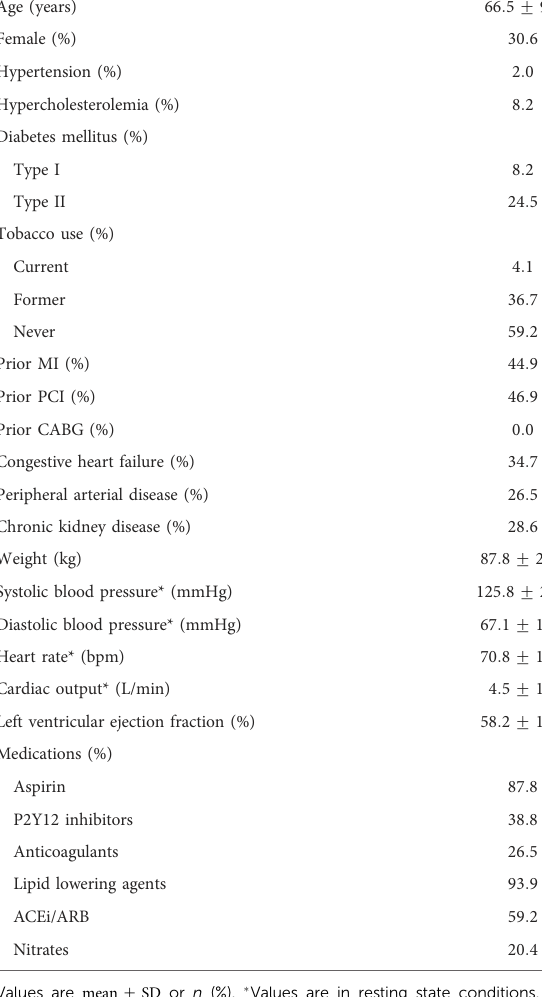
( Figure 4 ) indicated that cardiac output and stenosis degree contributed most to the variance in FFR. Distal location and mean arterial pressure also exceeded the threshold for sensitivity, but contributed less to the variance in FFR than cardiac output and stenosis degree. While distal location exceeded the threshold for signi fi cance, Sobol indices are relative metrics and the effect sizes of cardiac output and stenosis degree exceeded distal location. To minimize the number of parameters, we created two streamlined models. FFR semi (cid:1) streamlined incorporated patient-generalized mean